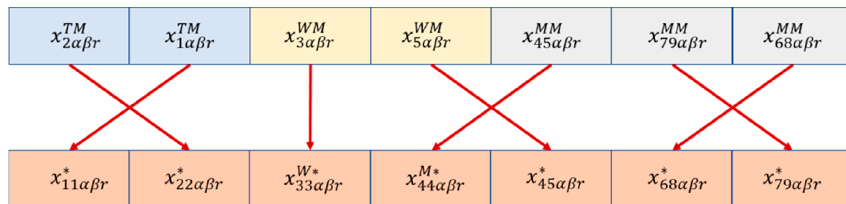
Figure 9. Transformation of three different assignment matrices into one virtual assignment matrix.